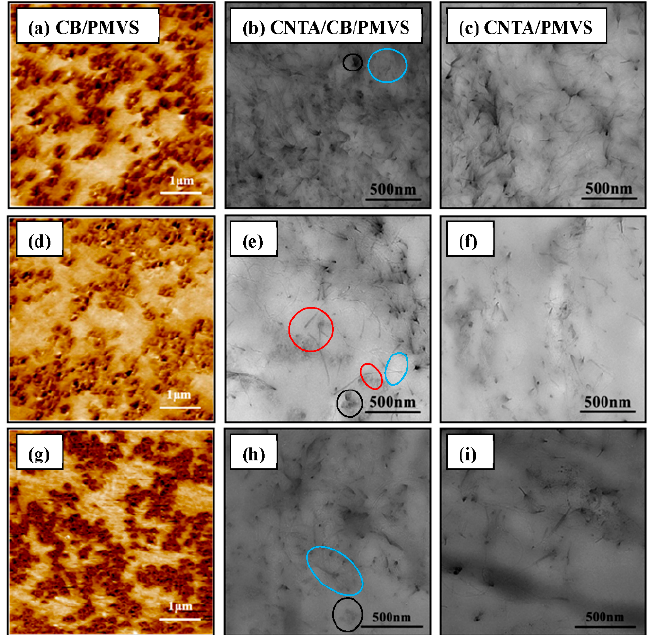
Figure 8. ( a ), ( d ), ( g ) AFM adhesion micrographs of CB/PMVS composites with 3 vol % of CB; ( b ), ( e ), ( h )TEM micrographs of the composites with 3 vol % of CNTA and CB; ( c ), ( f ), ( i ) TEM micrographs of the composites with 3 vol % of CNTA; images ( d – f ) refer to the corresponding composites after extension; images ( g – i ) refer to the corresponding composites after 10 4 repeated stretch-recovery cycles under fixed tensile strain 30%. The CNTAs and CB are shown in the blue and black oval area, respectively, in Figure 8b,e,h. The overlap between CNTs and CB is shown in the red oval area in Figure 8e.